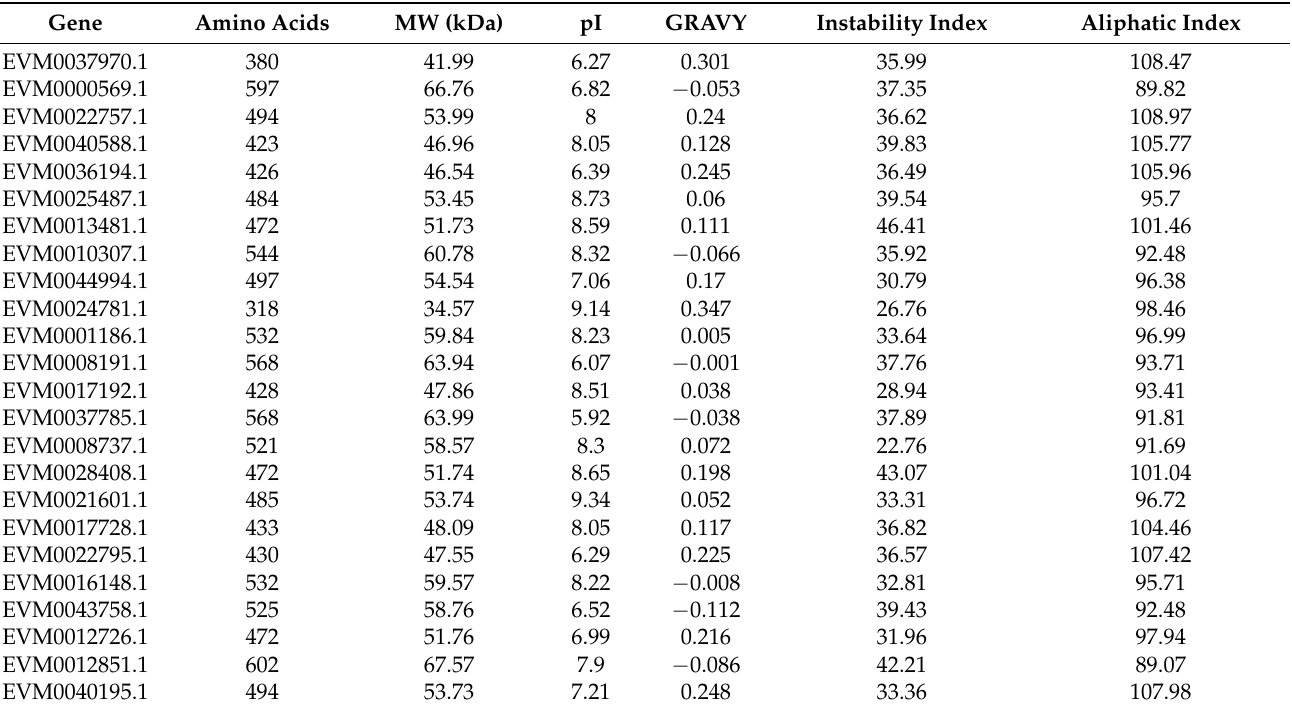
Table 2. Physiological and biochemical properties of EjALMT